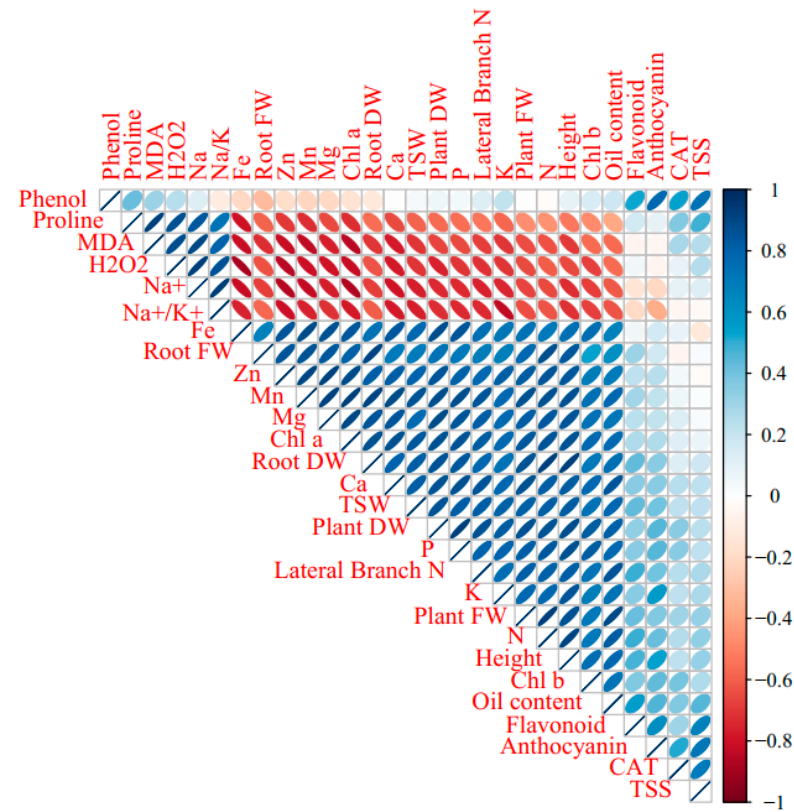
Figure 1. Pearson’s correlation heat map of NaCl salinity × foliar applications (distilled water, salicylic acid, cerium oxide nanoparticles, and CeO 2 :SA-nanoparticles) on the growth, physiological responses, and elemental content in Portulaca oleracea plants. FW & DW refers to fresh and dry weight, respectively.